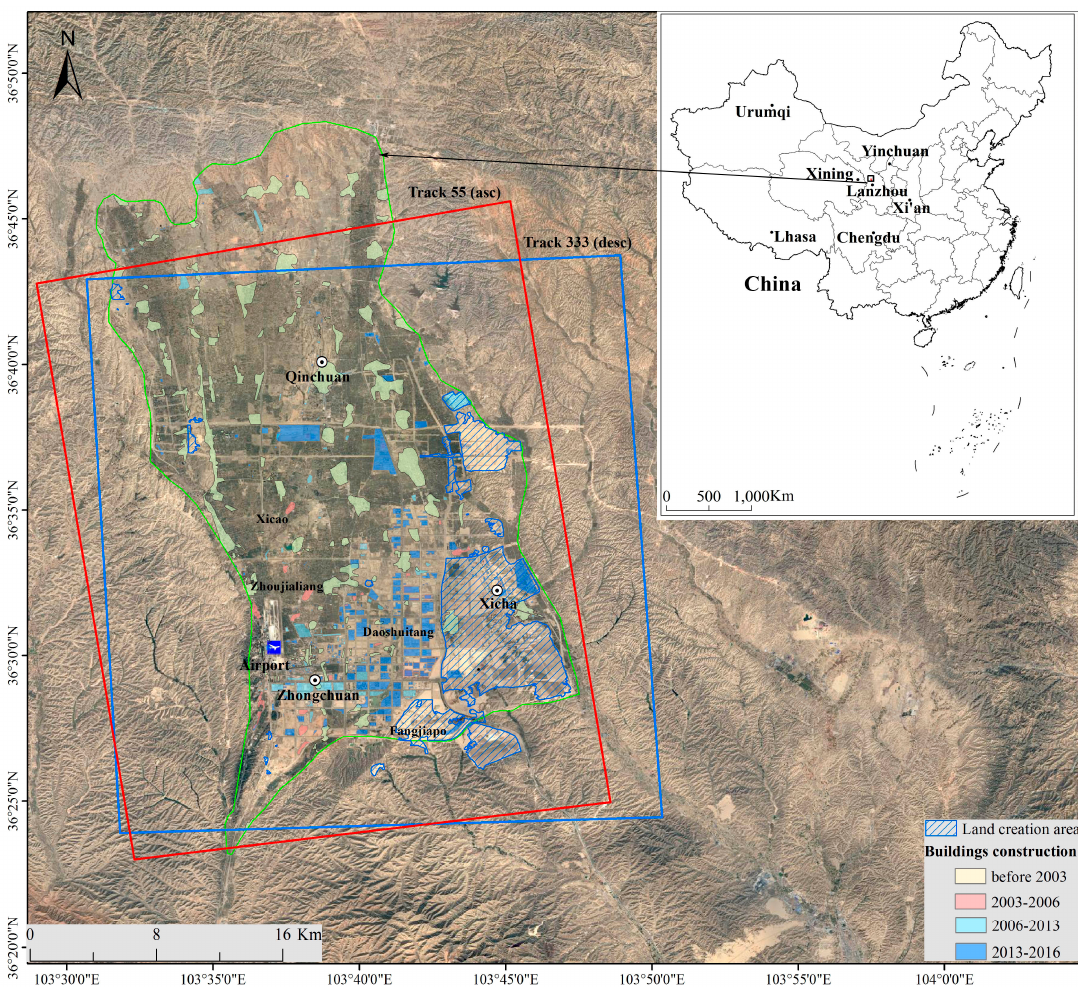
Figure 1. Location of Lanzhou New District (LZND) as covered by the Satellite image obtained on 14 October 2015. Blue and red rectangles indicate the areas covered by the Envisat and Sentinel-1A images, respectively.